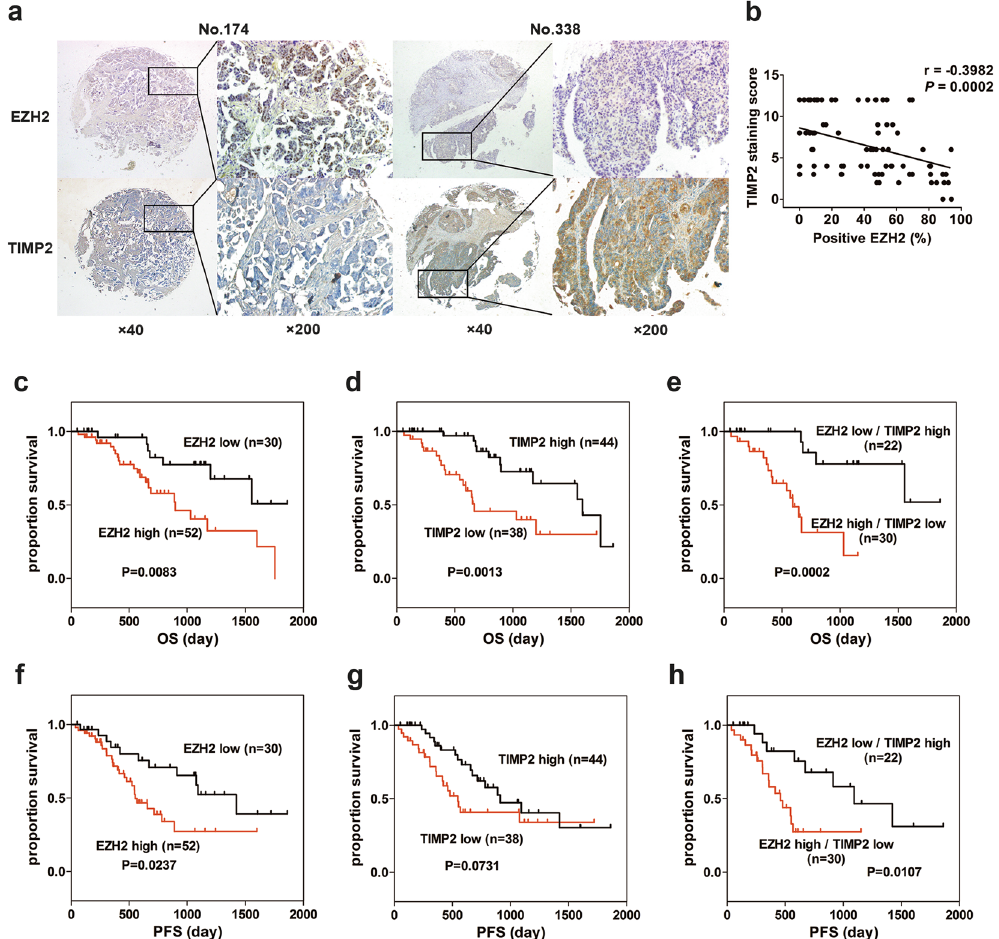
nucleus, while TIMP2 was expressed in the cytoplasm. Sample No. 174 has high EZH2 expression and low TIMP2 expression. Sample No. 338 has low EZH2 expression and high TIMP2 expression (scale bar, 50 μ m). ( b ) Negative correlation between the percentage of EZH2-positive cells and the TIMP2 staining score in ovarian cancer tissues (Spearman’s correlation test). ( c – e ) Kaplan-Meier plots for overall survival in epithelial ovarian cancer patients. High EZH2 ( c ), low TIMP2 ( d ) or high EZH2 and simultaneous low TIMP2 ( e ) are associated with reduced overall survival. ( f – h ) Kaplan-Meier plots for progression-free survival in patients with epithelial ovarian cancer stratified by the expression status of EZH2 ( f ), TIMP2 ( g ), or both EZH2 and TIMP2 ( h